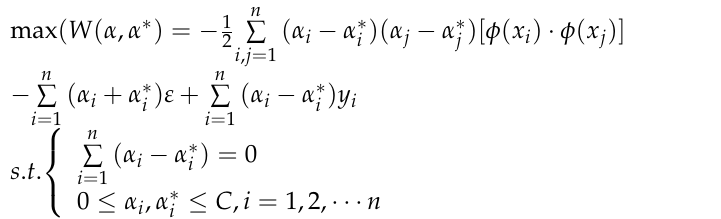
Figure 3. Schematic diagram of the support vector regression. It is generally solved by introducing the Lagrange function and using its pair- wise